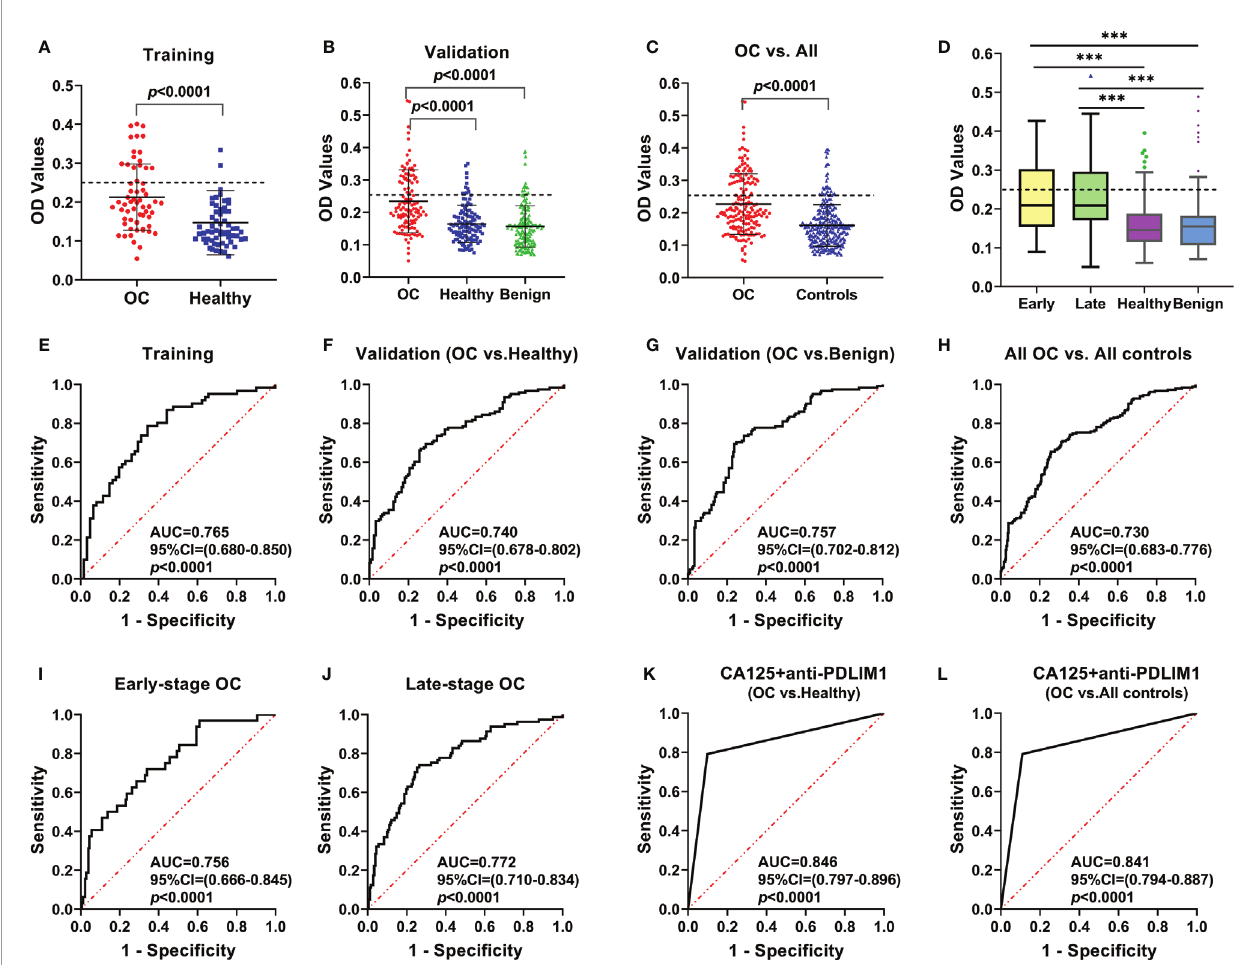
FIGURE 3 | Theexpressionandthediagnosticperformanceofanti-PDLIM1AAbinOC. Theexpressionlevelofanti-PDLIM1AAbinthetrainingset (A) , validationset (B) ,allOC andallcontrols (healthy+benign) (C) ,early-stage andlate-stageofOC (D) . Thecut-offvalue(dottedline)wasdeterminedbythemaximumYoudenindexwiththespeci fi cityof 90%.Thediagnosticperformanceofanti-PDLIM1AAbinthetrainingset (E) , validation set (F, G) , allOC andallcontrols(healthy+benign) (H) ,early-stageOC (I) , late-stageOC (J) . The diagnosticperformance ofanti-PDLIM1 AAbincombinationwithCA125for identifyingOCfrom healthycontrols (K) orallcontrols(healthy+benign) (L) .*** p false negative rate (FNR), positive predictive value (PPV), and negative predictive value (NPV) were analyzed among different groups ( Table 3 ). As shown in Figures 3E, F , the areas under the curve (AUC) for identifying OC from healthy controls in training